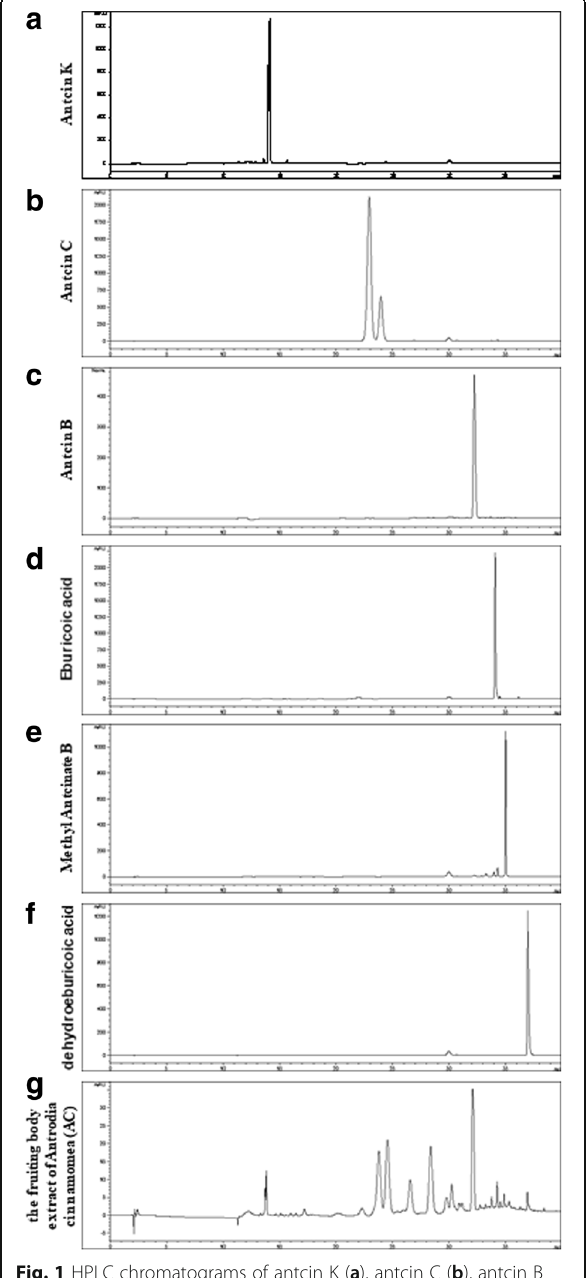
Fig. 1 HPLC chromatograms of antcin K ( a ), antcin C ( b ), antcin B ( c ), eburicoic acid ( d ), methyl antcinate B ( e ), dehydroeburicoic acid ( f ) and the extract of Antrodia cinnamomea (AC) ( g